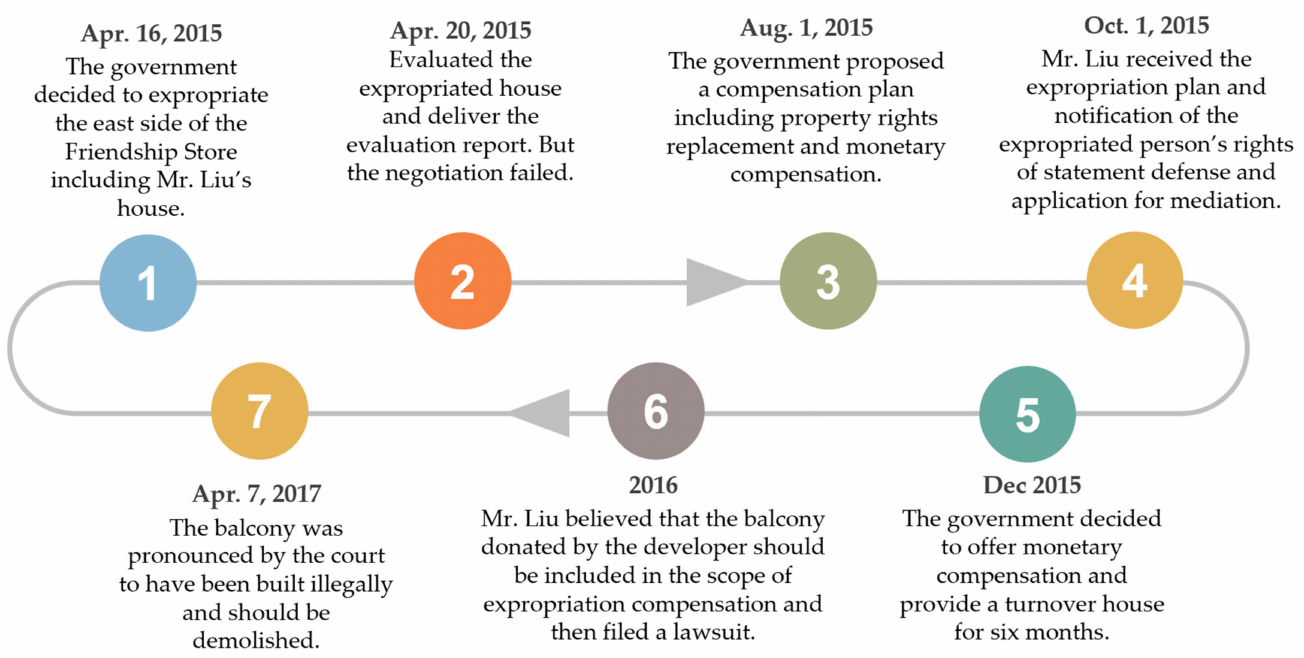
Figure 2. The expropriation timeline of the east side of the Friendship